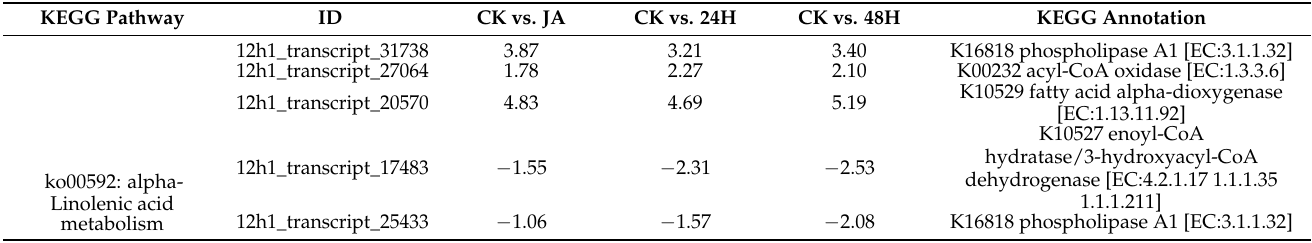
Table 2. Overlapping differentially expressed genes related to flavonoid biosynthesis, alpha-linolenic acid metabolism, and phenylpropanoid biosynthesis detected in different